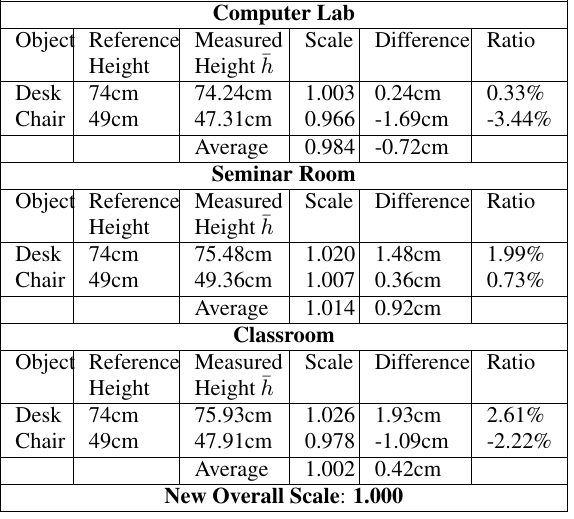
Table 3: Table showing the effect of scaling each scene such that the objects are closer to their respective reference height.